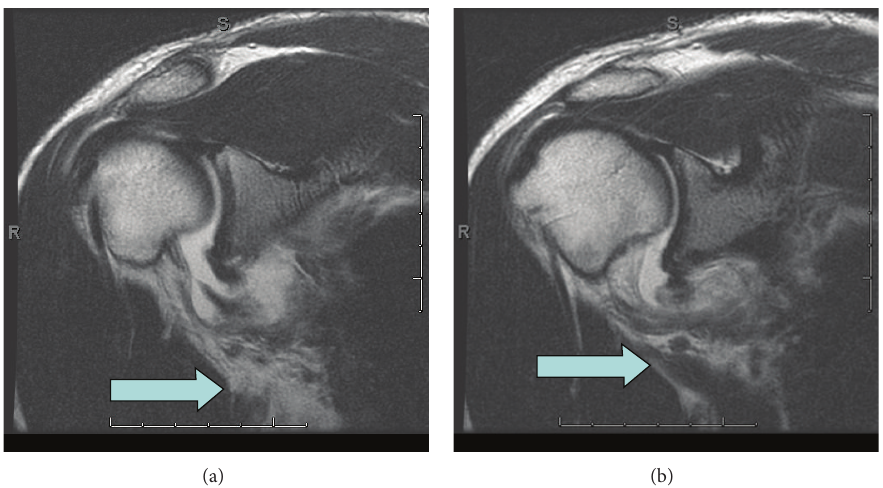
Figure 3: Case 11 . Oblique coronal T2 demonstrates joint fluid extending into quadrilateral space (arrow).